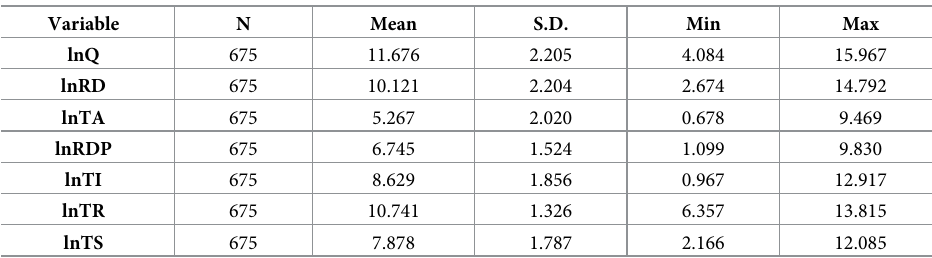
Table 1. Descriptive statistics.